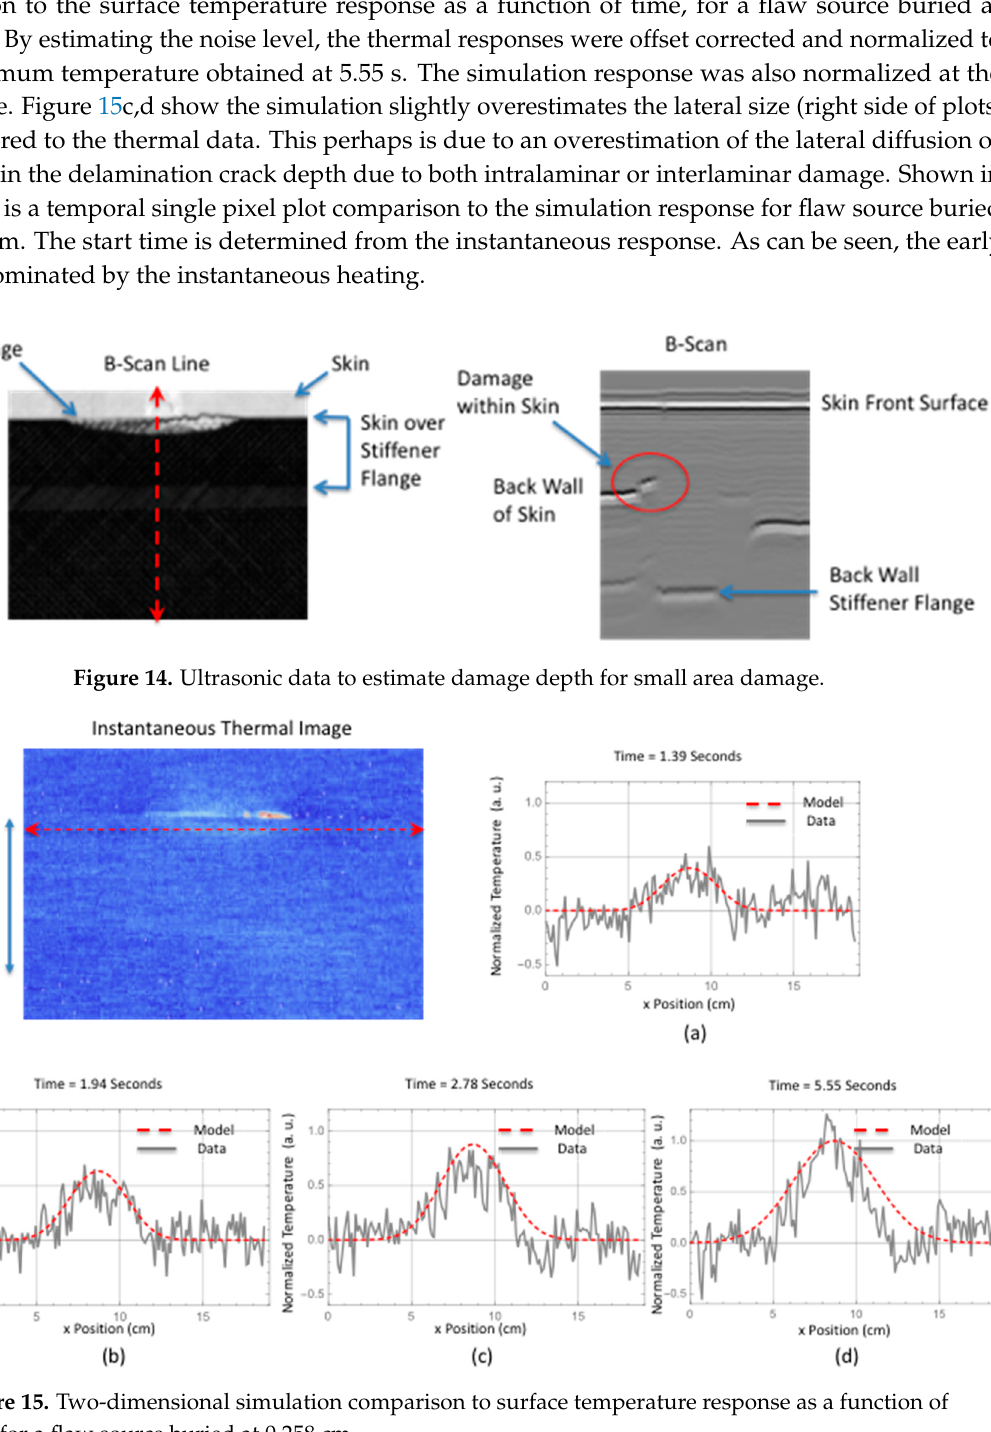
Figure 16. Temporal pixel plot comparison to model response for flaw source buried at 0.258 cm. Shown in Figure 17 is the ultrasonic B-scan inspections for the large area failure where the damage is at multiple interfaces. The B-scan images reveals estimated damage depth within the skin to be from one ply deep (B-Scan: a and c) and two plies deep (B-Scan: b). The skin is 12 plies thick. The thermally determined damage width, from Table 2 for a line within the delamination located halfway up toward hat, was used in the simulation.